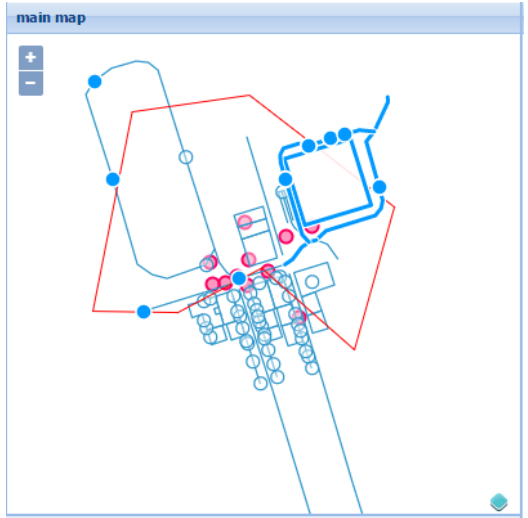
Figure 9. Main map view with a dropped overlaying polygon (note: the light blue features depict OSM features, the red circles represent Panoramio photos, the highlighted blue features represent the features that have been selected, and the red feature depicts the dragged polygon).